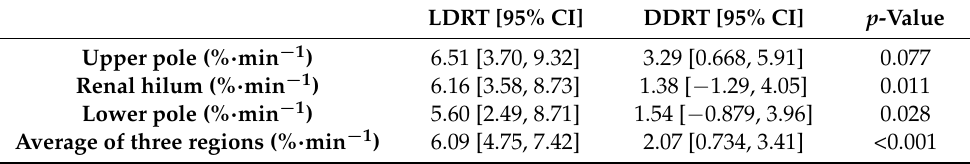
Figure 2. Linear regression analysis of tissue oxygen saturation (rSO 2 ) levels of the kidney allograft in living ( n = 3, solid turquoise line and closed circles) and deceased donor renal transplants ( n = 4, dash red line and closed triangles) over 5 min (mins) after reperfusion. Trend lines and R 2 coefficients of tissue oxygen saturation levels measured at three regions (upper pole, renal hilum, and lower pole) of the kidney allograft over 5 min of reperfusion in living and deceased donor renal transplants were calculated using linear regression analysis. ( A ) Trend lines and R 2 coefficients of tissue oxygen saturation levels measured at the upper pole of the kidney allograft. ( B ) Trend lines and R 2 coefficients of tissue oxygen saturation levels measured at the renal hilum of the kidney allograft. ( C ) Trend lines and R 2 coefficients of tissue oxygen saturation levels measured at the lower pole of the kidney allograft. ( D ) Trend lines and R 2 coefficients of average tissue oxygen saturation levels measured at three regions of the kidney allograft. Trend line equations, R 2 coefficients, and p -values for living and deceased donor renal transplants are displayed in matching colors. Data are expressed as mean ± SEM. Table 3. Comparison of the rates of change in tissue oxygen saturation (rSO 2 ) levels per minute at three regions (upper pole, renal hilum, and lower pole) of the kidney allograft calculated from linear regression analysis over 5 min of reperfusion in living and deceased donor renal